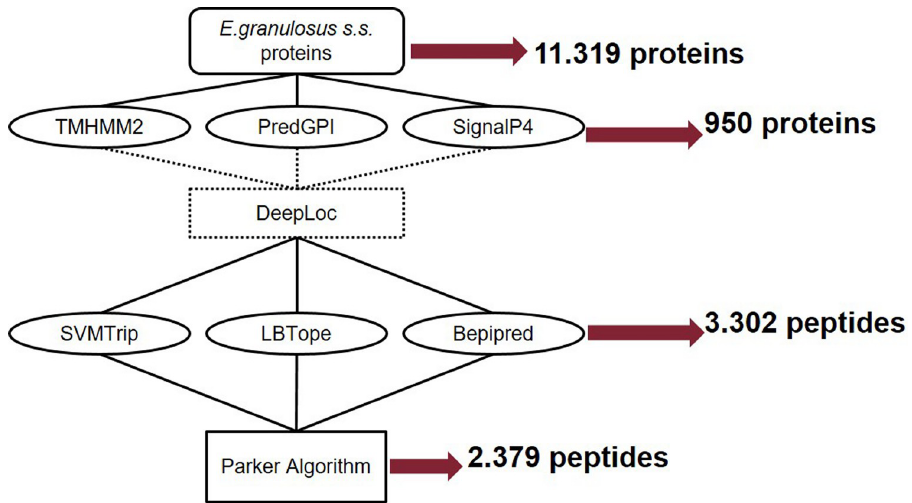
Fig 1. Bioinformatics and experimental workflow to identify most exposed proteins and immunogenic peptides starting from the E . granulosus s.s. genome. Starting from all proteins predicted from the genome, TMHMM2, SignalP4 and predGPI software identified the most exposed proteins of E . granulosus . The localization of these proteins was further evaluated using the DeepLoc software and all proteins were retained for the second step of the pipeline to determine specific B-cell antigenic epitopes through Bepipred, SVMTrip e LBTOPE software. All peptides were filtered to avoid redundancy. Finally, peptides were screened according to the hydrophilicity characteristics using the Parker’s